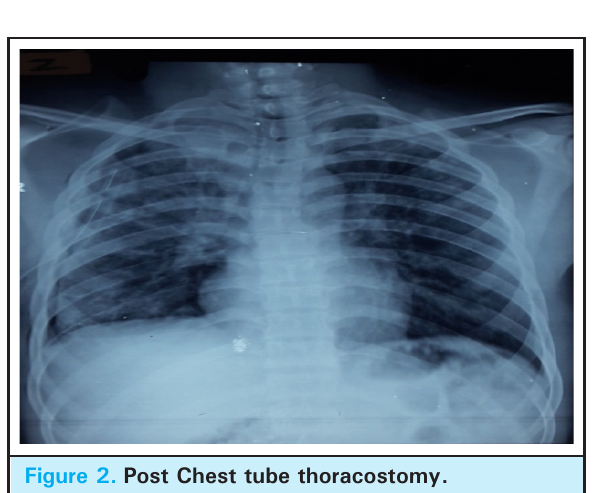
Figure 2. Post Chest tube